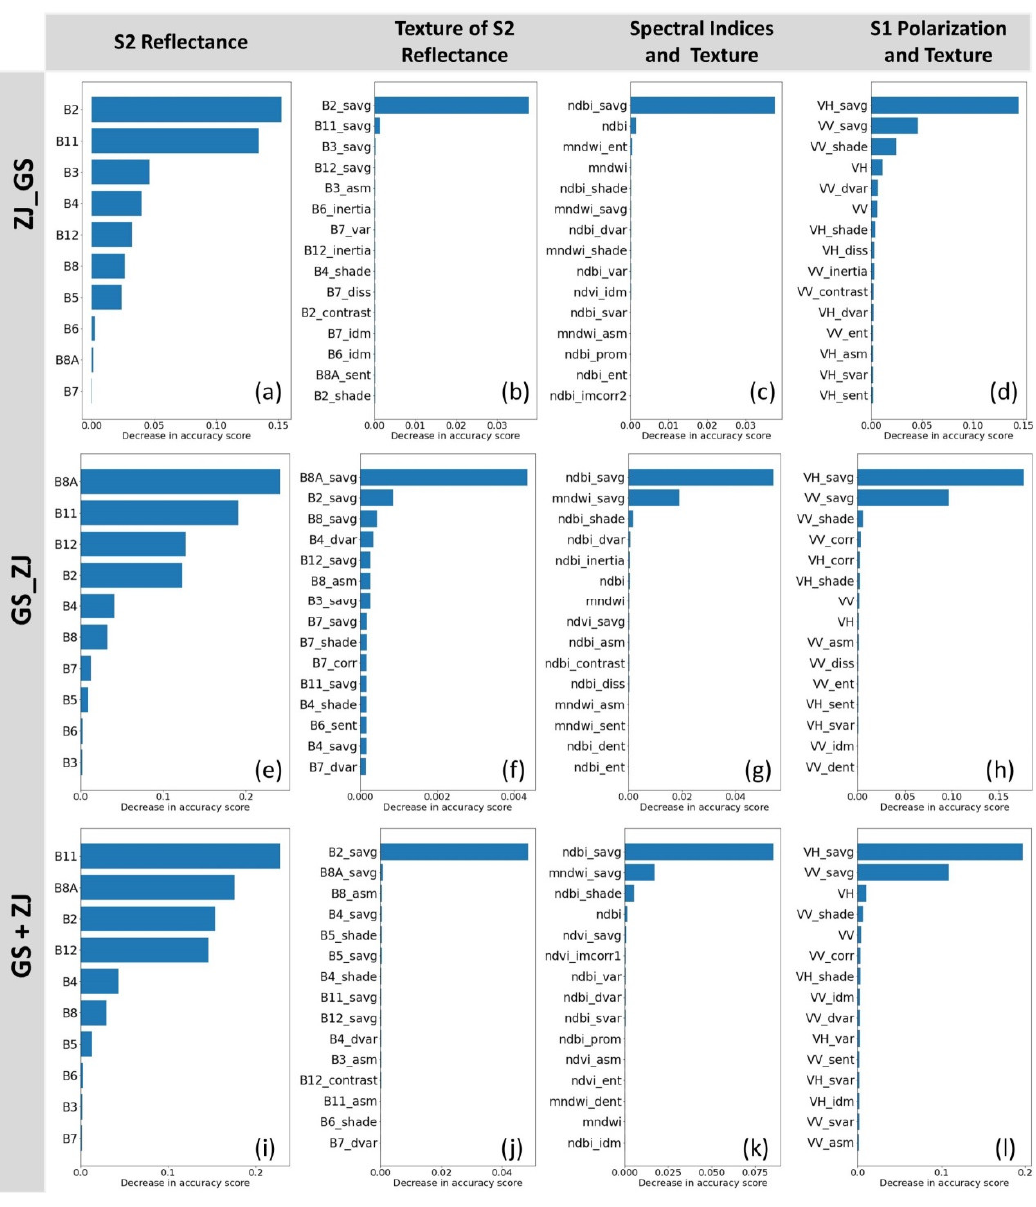
Figure 5. Permutation importance of different features in four feature groups in the three classification schemes. ( a – d ) are importance of features in classification scheme ZJ_GS; ( e – h ) are importance